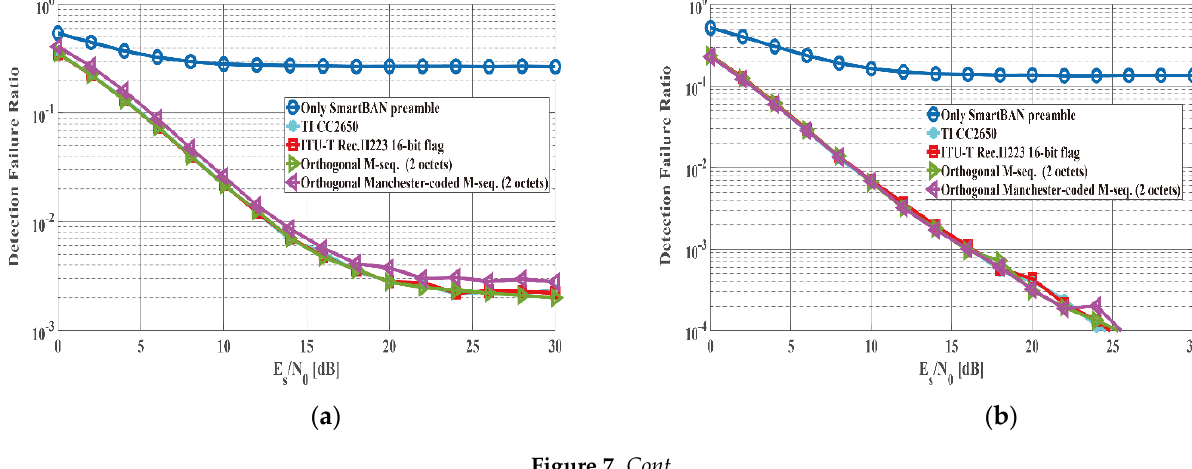
( d ) Figure 7. PLCP header detection failure ratio in the case of several modulation schemes under the IEEE channel CM3 (medium shadowing case, K = 4.5). ( a ) GFSK (SmartBAN). ( b ) QPSK. ( c ) 𝜋 4⁄ -DQPSK. ( d ) D8PSK. ( a )